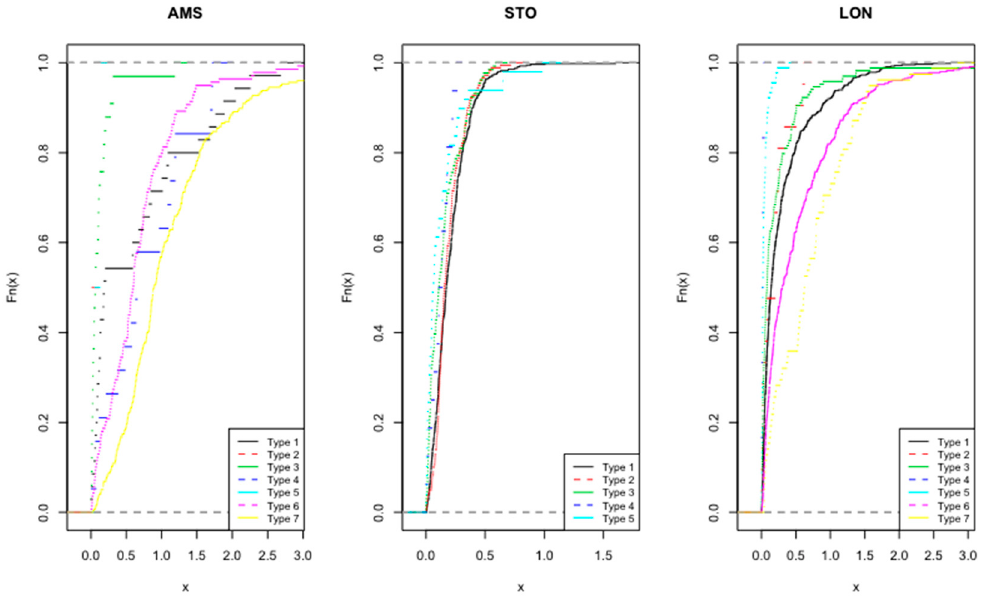
Figure A6. Distribution function of dependent variable of economic activity concentration across plot types in three cities.